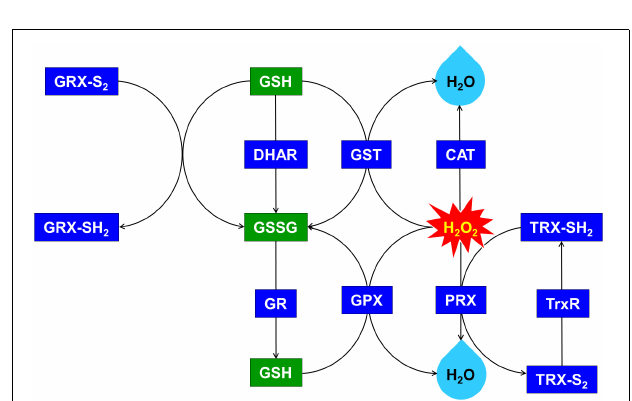
FIGURE 6 | Upregulated glutathione (GSH)-dependent antioxidant system and maintenance of cellular redox status through the overexpression of OsDHAR in S. elongatus . GRX, glutaredoxin; GST, glutathione S -transferase; GR, glutathione reductase; GPX, glutathione peroxidase; CAT, catalase; PRX, peroxiredoxin; TRX, thioredoxin; TrxR, thioredoxin reductase. qRT-PCR identified GSH-related genes that were annotated in Supplementary Figure S3